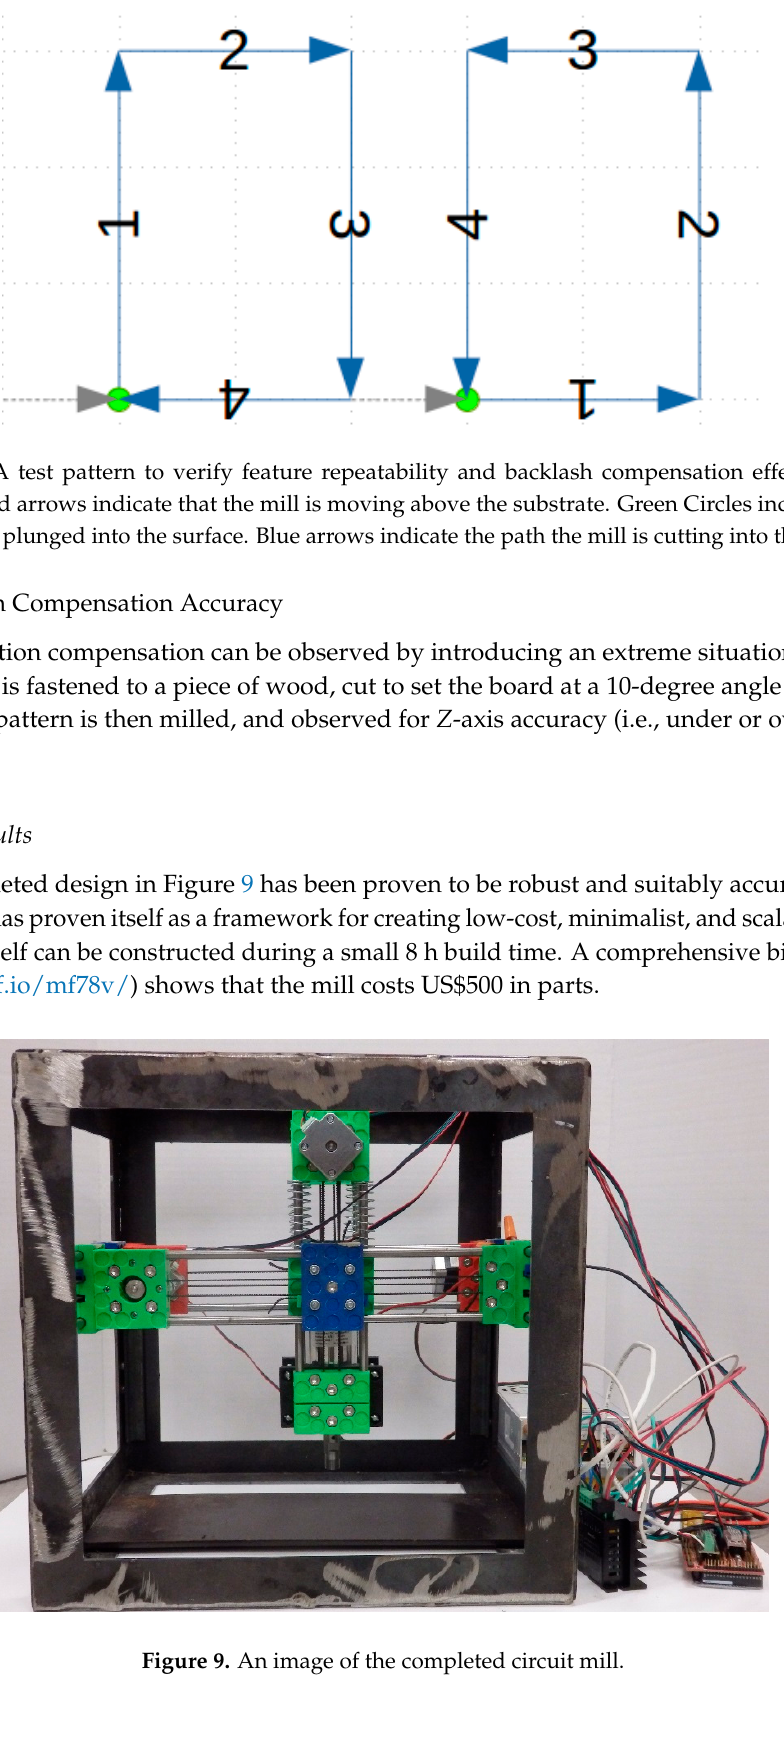
Figure 9. An image of the completed circuit mill.